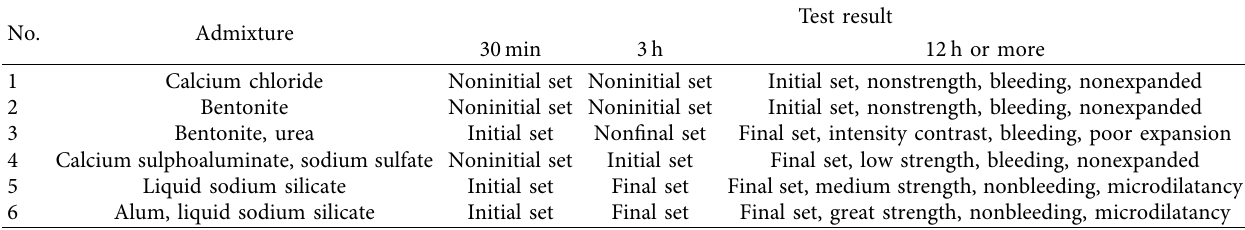
Table 1: Admixture test